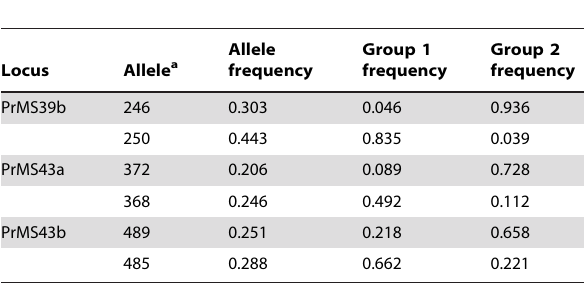
Table 3. Influential loci and alleles in Structure 2.2